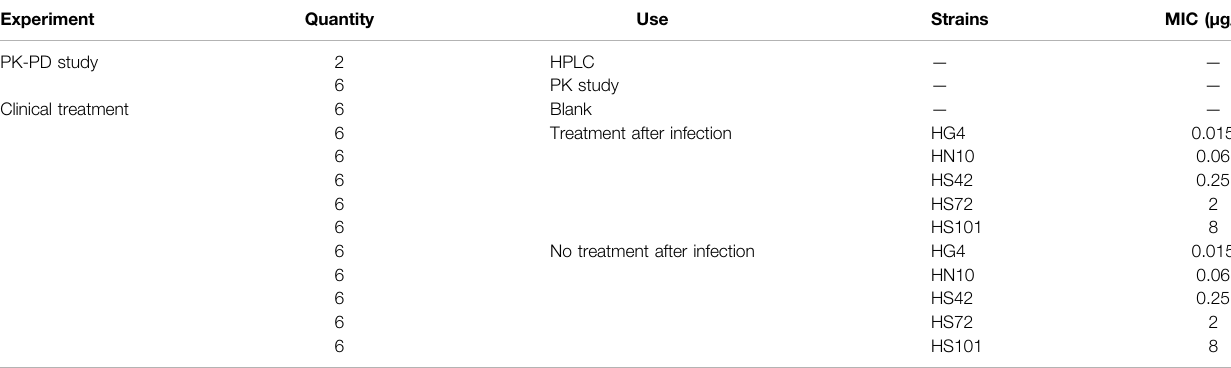
TABLE 1 | Experimental grouping of pigs used in the study.